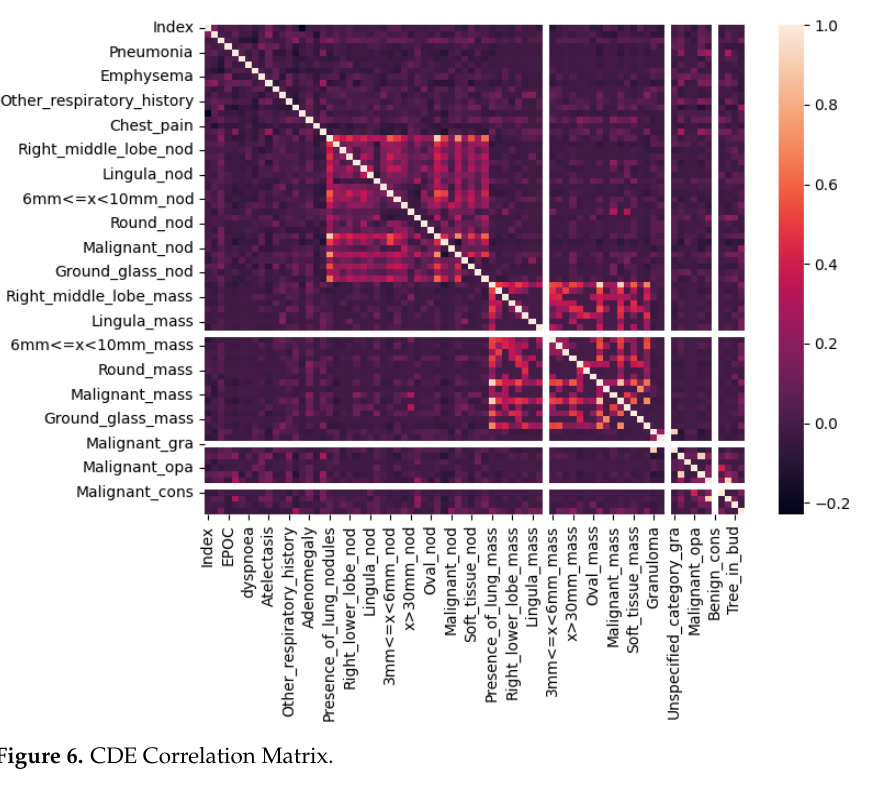
Figure 6. CDE Correlation Matrix.